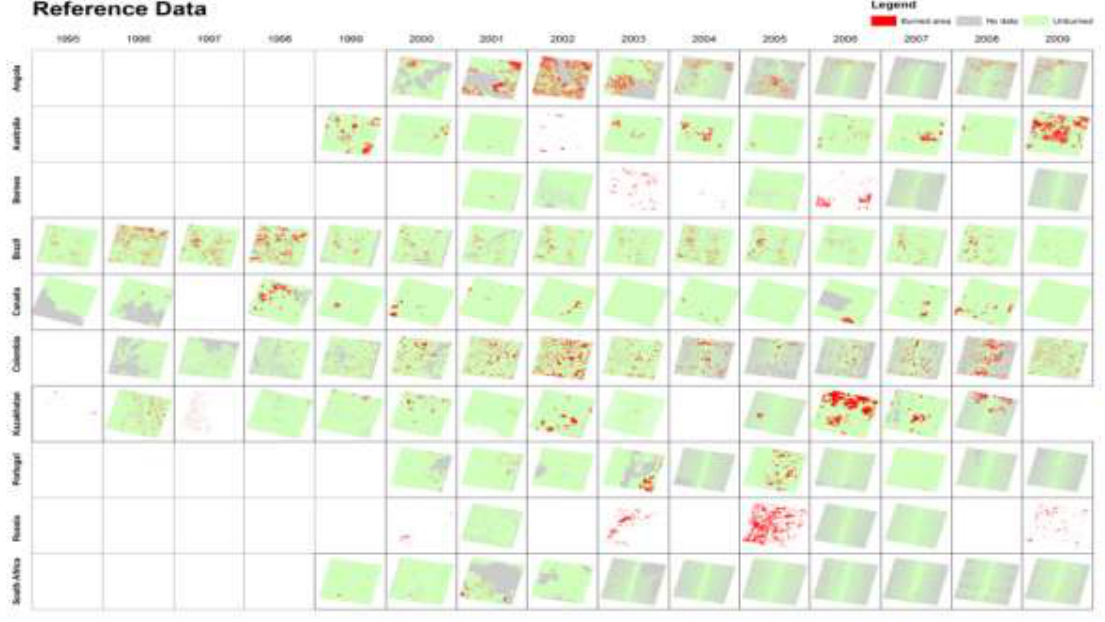
Figure 3: Time series of reference BA areas derived from multitemporal pairs of Landsat TM/ETM+ images for the study